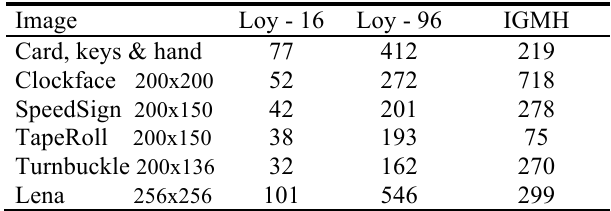
Table 3. Radial Symmetry Detection Time